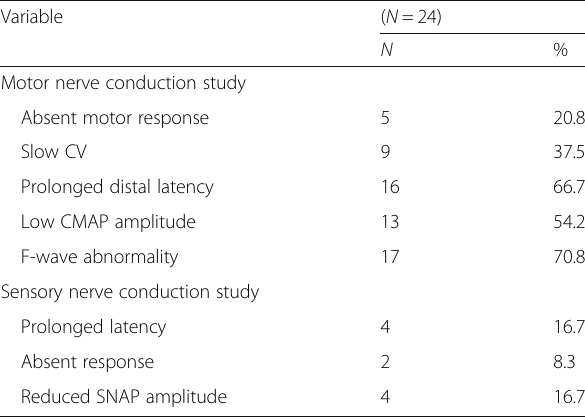
Table 4 Motor and sensory nerve conduction study findings